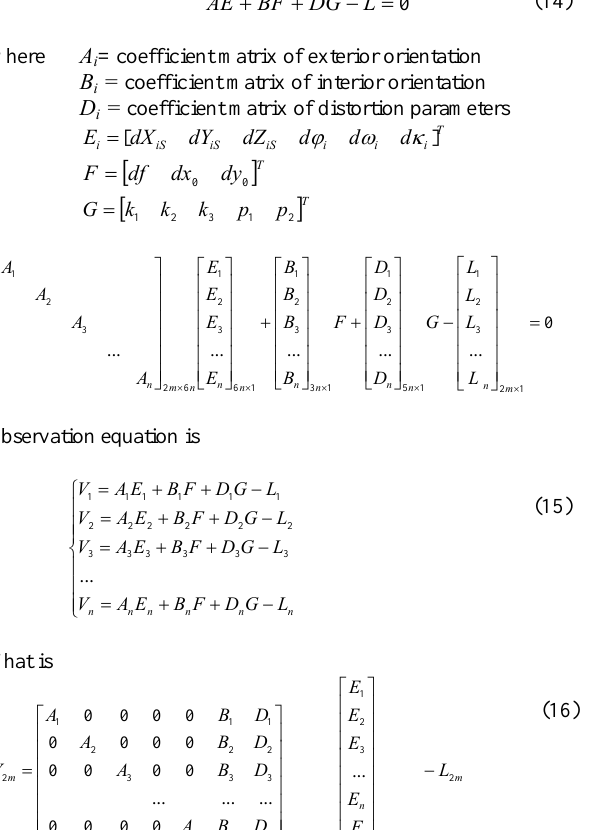
Figure3 UI of Calibration